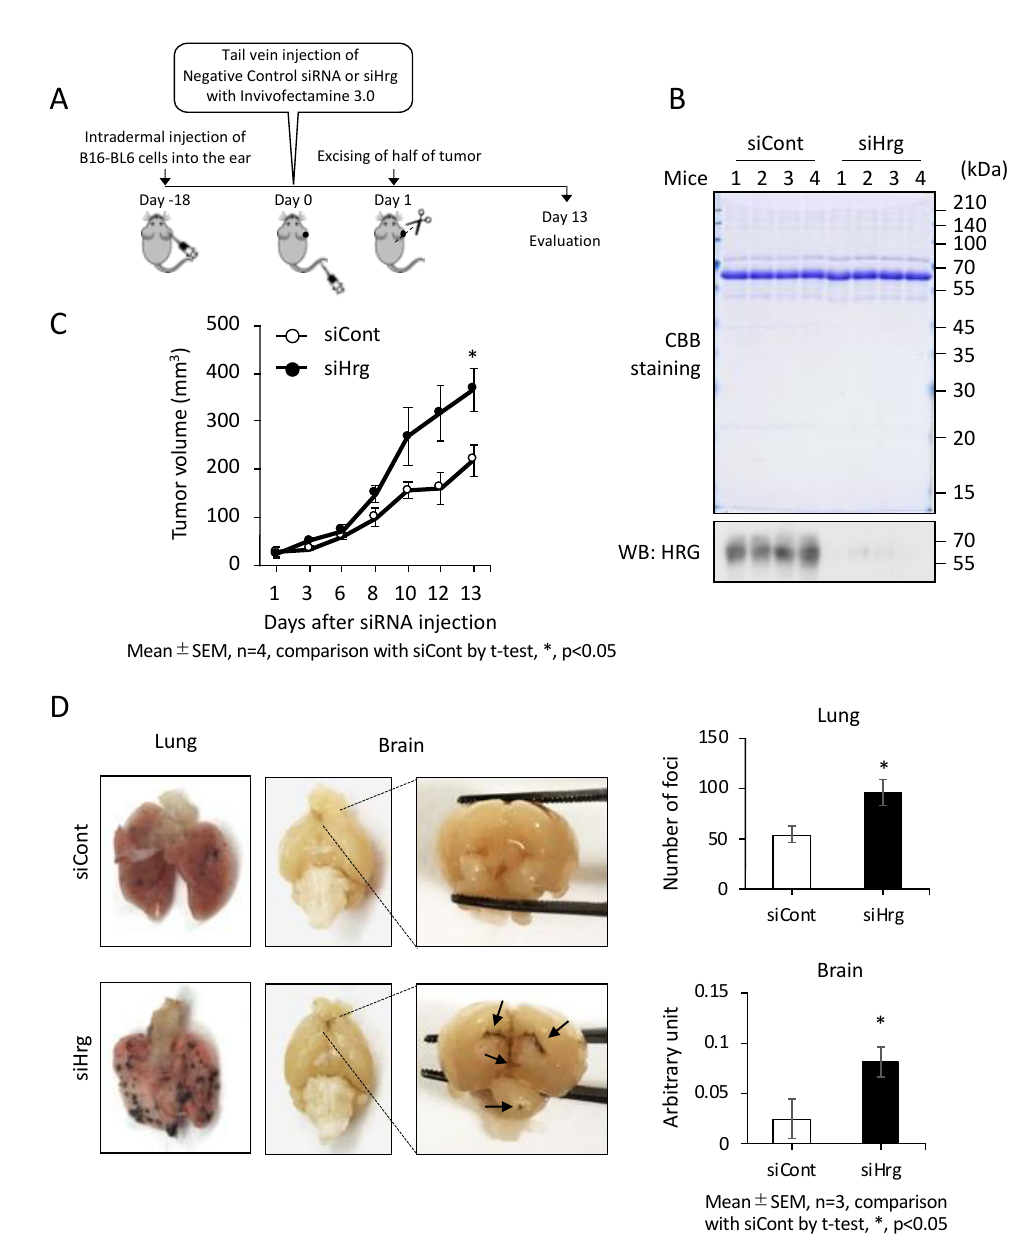
Figure 3. Evaluation of the anti-cancer role of the intrinsic HRG in a mouse model. ( A ) Schematic representation of the timeline of autonomous metastatic tumor progression in C57BL/6J mice bur- dened with mouse melanoma (B16-BL6) cells). siHrg or siCont was injected into mice 18 days after the inoculation of melanoma cells (see Materials and Methods for details). ( B ) On day 13, blood specimens (0.5 µL) were collected from the hearts of all mice and used to confirm that the HRG protein level was lower in the siHrg-treated mice than in the siCont-treated mice. ( C ) The volumes of B16-BL6 cell derived tumors grown in the individual ears were measured on the indicated days. ( D ) Lung and brain metastases were monitored by assessing the region of black tissue (melanoma) in images of dissected mouse lungs and brain ( left ). The clear black foci in the lungs that were greater than 1 mm in diameter were counted as metastatic foci ( upper-right image). To evaluate brain metastasis, the intensity of the black area was measured using ImageJ software (lower-right image). Arrows indicate the sites of metastasis. Data are means ± SD. * p < 0.05 by Student’s t -test.